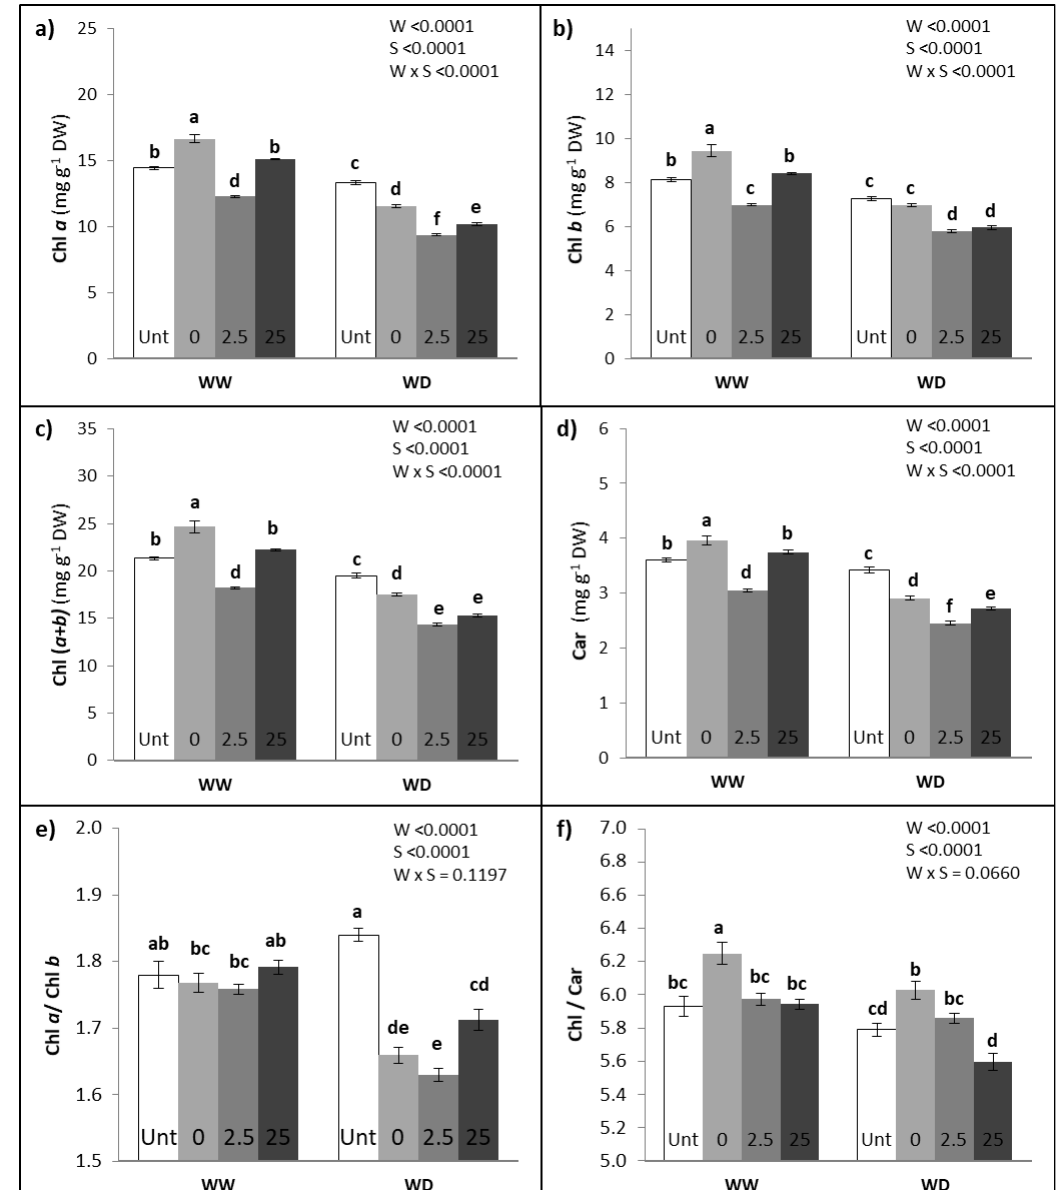
Figure 6. Chlorophyll a (Chl a )—( a ); chlorophyll b (Chl b )—( b ); chlorophyll a + b (Chl a + b )—( c ); chlorophyll ratio (Chl a/ Chl b )—( d ); carotenoids (car)—( e ) and chlorophyll/carotenoids ratio (Chl/Car)—( f ) from wheat plants expressed per unit of dry weight (DW). Two water treatments (W) and four soaking treatments (S) were studied. Values are means ± SE ( n = 12). Different letters indicate statistically significant differences ( p < 0.05).